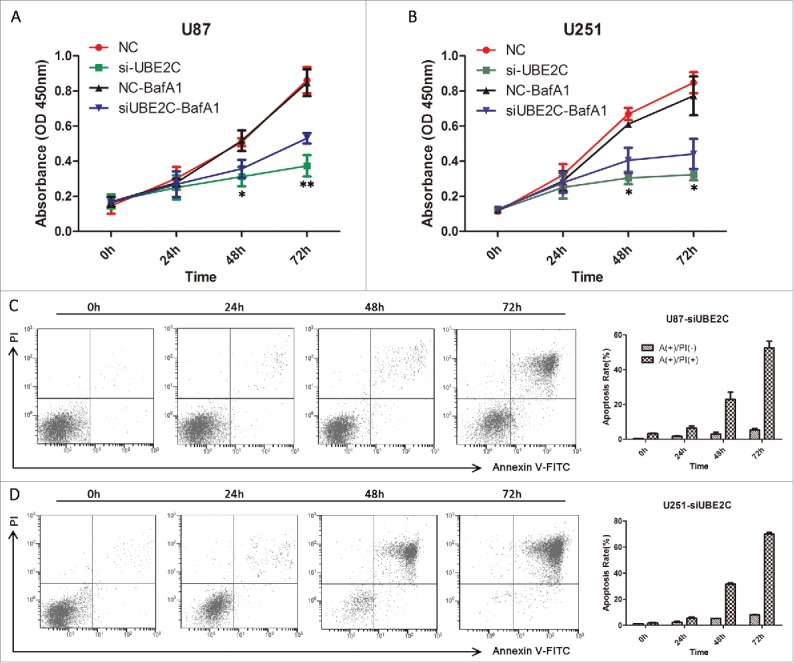
si-UBE2C inhibits cell viability, which can be abrogated by BafA1, but does not induce obvious apoptosis. U87-MG and U251 cells were first transiently transfected with si-NC or with si-UBE2C for 48 h (A-B) and were consequently treated with BafA1 at 10 nM for 1.5 h. Then, relative cell viabilities were measured using a CCK-8 assay at 24, 48 and 72 h. All CCK-8 assay results were obtained from three independent experiments, *p < 0.05. (C-D) In each panel, the lower left quadrant shows viable cells (Annexin V-FITC and PI negative), the lower right quadrant shows cells in early apoptosis (Annexin V-FITC positive and PI negative), the right upper panel shows cells that are at the end of apoptosis or are necrotic (Annexin V-FITC and PI positive), and the left upper panel shows damaged cells (Annexin V-FITC negative and PI positive). The percentages of cells in early and late apoptosis are shown in the histogram; *p < 0.05, **p < 0.01.